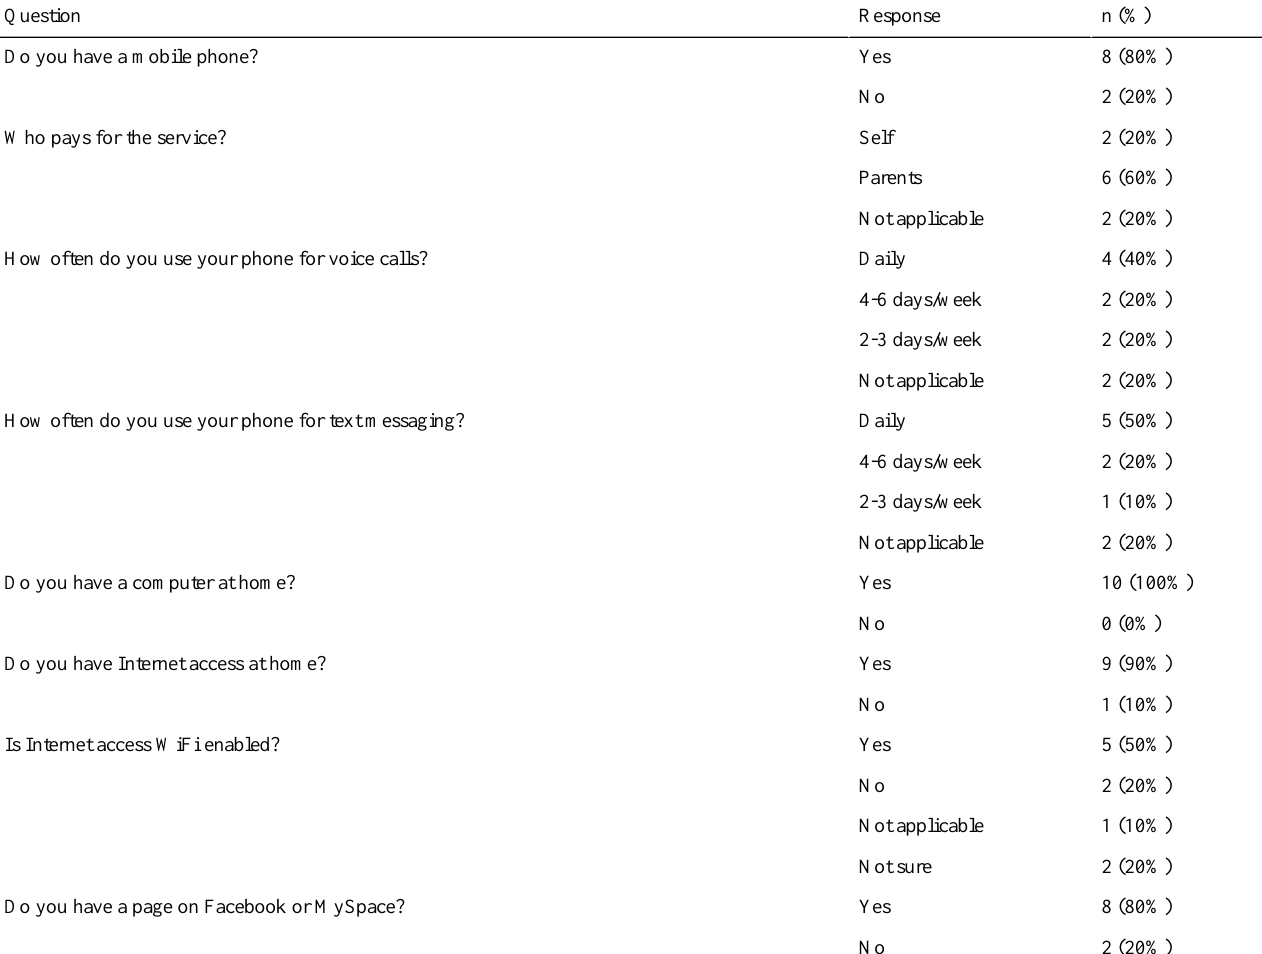
Table 2. Technology use among